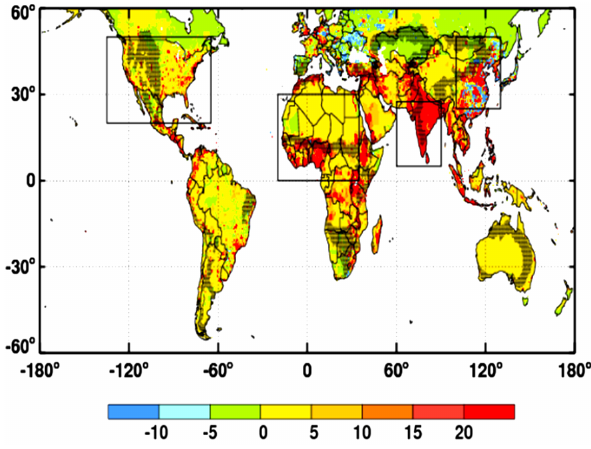
Figure 7. Global distribution of mean population change (per- sonskm − 2 ) .